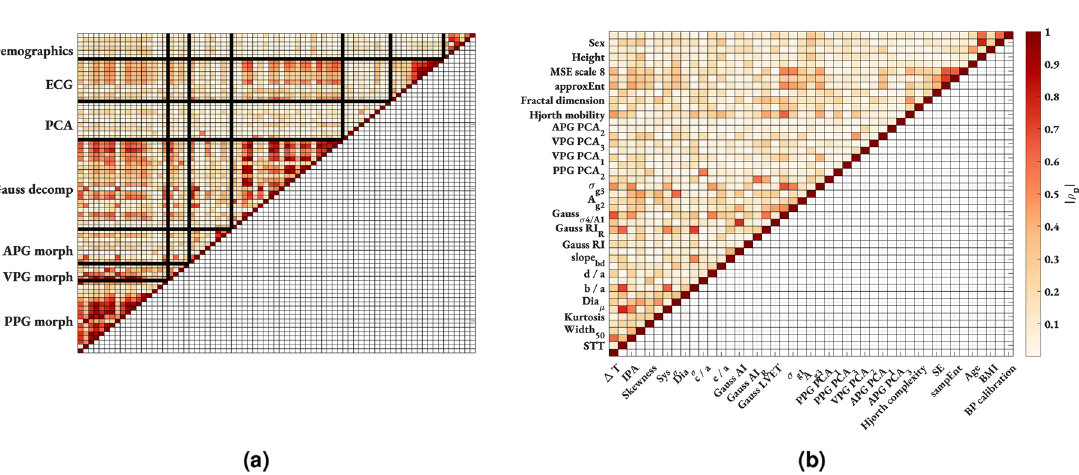
Figure 3. Results of removing collinear features in PPG + ECG feature set. Pairwise linear absolute Pearson’s | ρ p | correlation matrix. ( a ) pre and ( b ) post removal of collinear features. Blank spaces represent non-significant ( p > 0.05 ) or weak ( | ρ p | < 0.2 ) correlations. For clarity of labelling on the post-collinear feature set ( b ), every other label is presented on the y-axis with the remaining labels on the